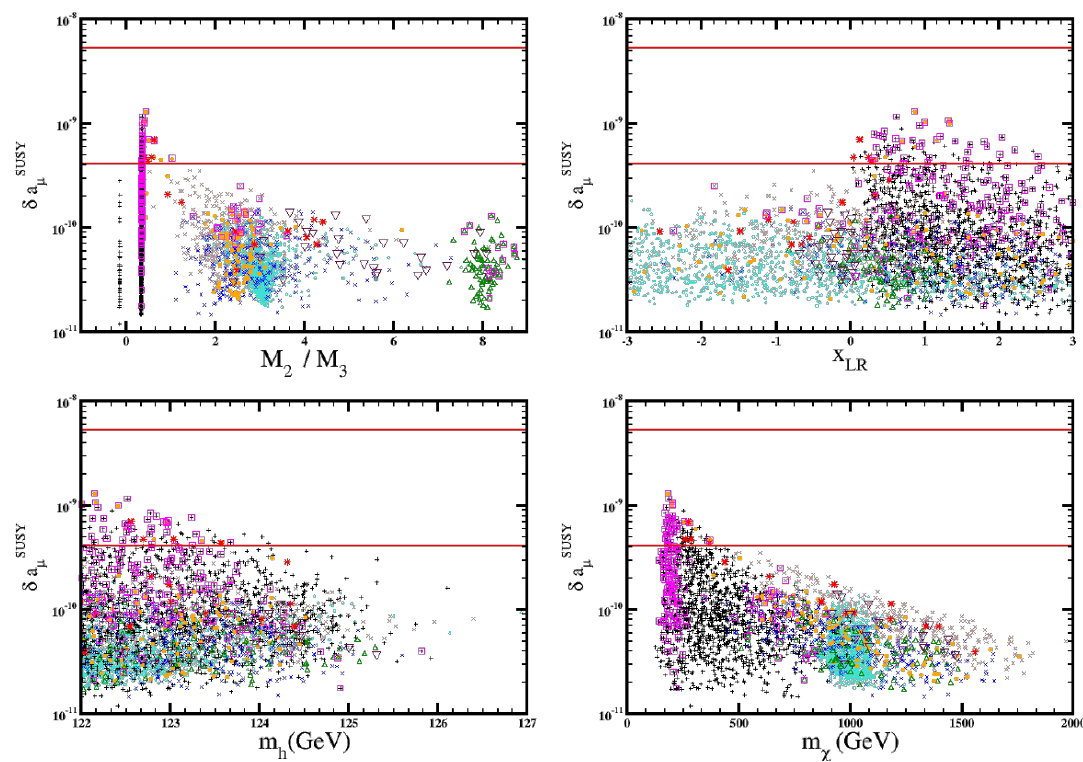
Figure 4 . The upper panels show the variation of the prediction for (cid:14)a SUSY GUT values of M 2 =M 3 (left) and the LR asymmetry of the GUT values for the sfermion masses (right). The lower panels show regions satisfying (cid:14)a SUSY (right). The red lines are the 3- (cid:27) bound lines for the experimental discrepancy of a (cid:22) with respect to the SM